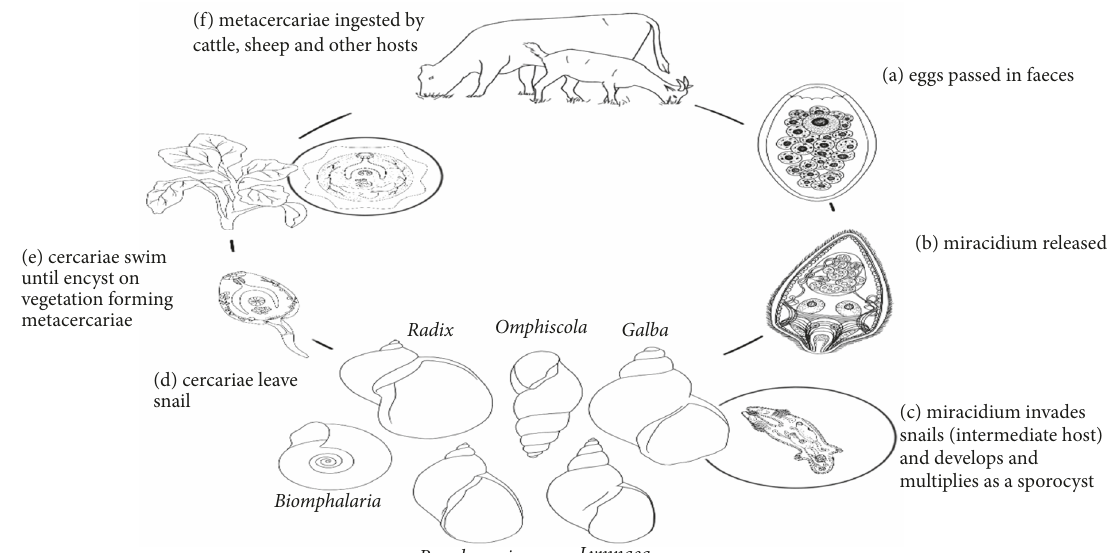
Figure 1: The life cycle of Fasciola in